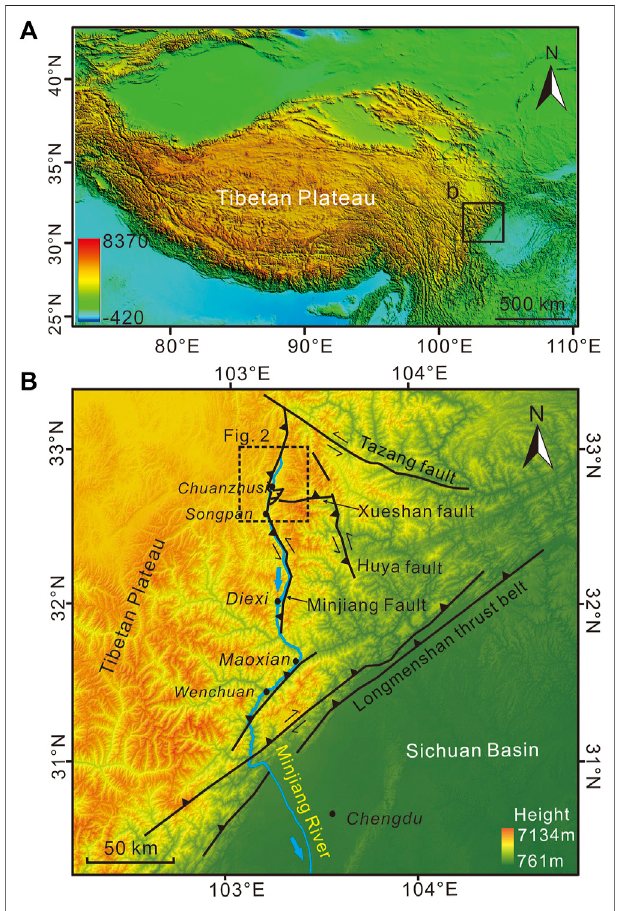
FIGURE 1 | DEM showing the location of the study area. (A) The MinjiangRiver issituatedontheeastern margin oftheTibetanPlateau closeto the Sichuan Basin, and (B) the enlarged image showing the reaches of the Minjiang River between its source and the basin, and the faults in the study area which are from Kirby et al. (2000) and Tan et al. (2019).